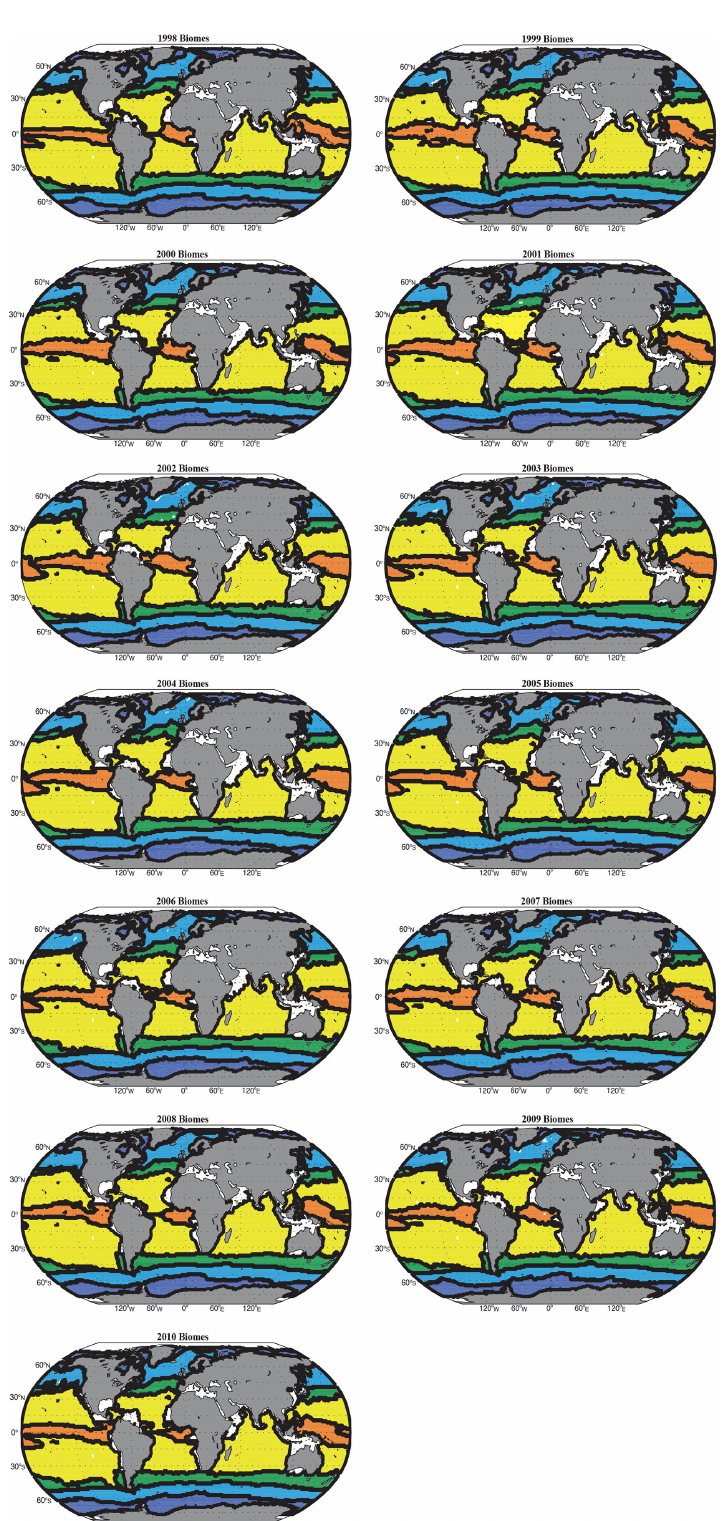
Figure 2. Time-varying biomes for years 1998–2010. Created from annual climatology of SST, summer mean Chl a , maximum ice fraction, and climatological maxMLD. Dark blue: ICE biome; cyan: SPSS biome; green: STSS biome; yellow: STPS biome; orange: EQU biome. White indicates ocean areas that do not fit the criteria for any biome and are excluded from further